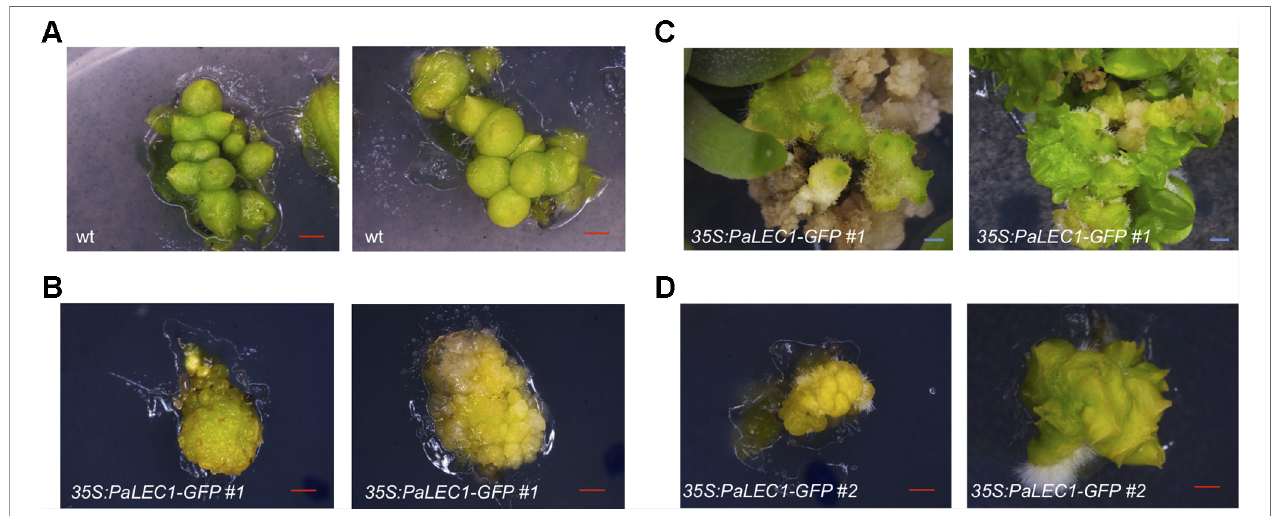
FIGURE 5 | Clonal propagation from protocorm-based explants of 35:PaLEC1-GFP#1 transgenic plants. (A) PLBs generated from cutting of wild-type protocorms. (B) Callus-like tissues produced by cutting of 35:PaLEC1-GFP#1 protocorms. (C) Callus-like tissues generated from 35:PaLEC1-GFP#1 grew into multiple-shoot like structures. (D) Callus-like and multiple shoot-like tissues produced by cutting of 35:PaLEC1-GFP#2 protocorms. For each panel, two independent clusters of tissues were photographed and showed. Red scale bar = 500 m m. Blue scale bar = 1